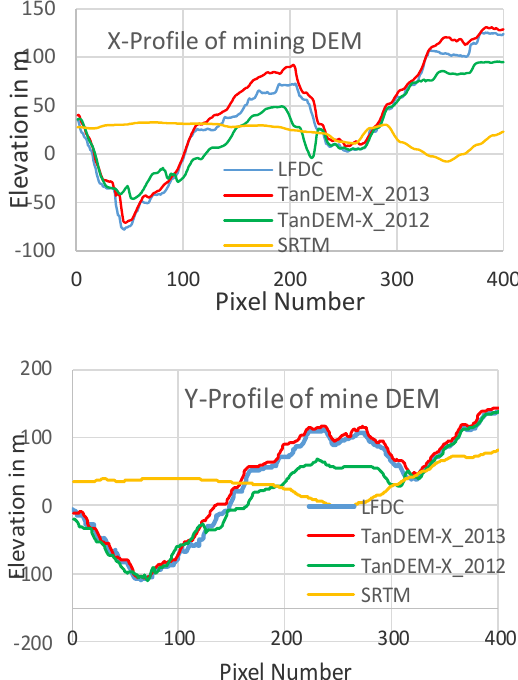
Figure 9. Elevation trend in X- and Y-direction of LFDC, TanDEM-X 2012, 2013 and SRTM